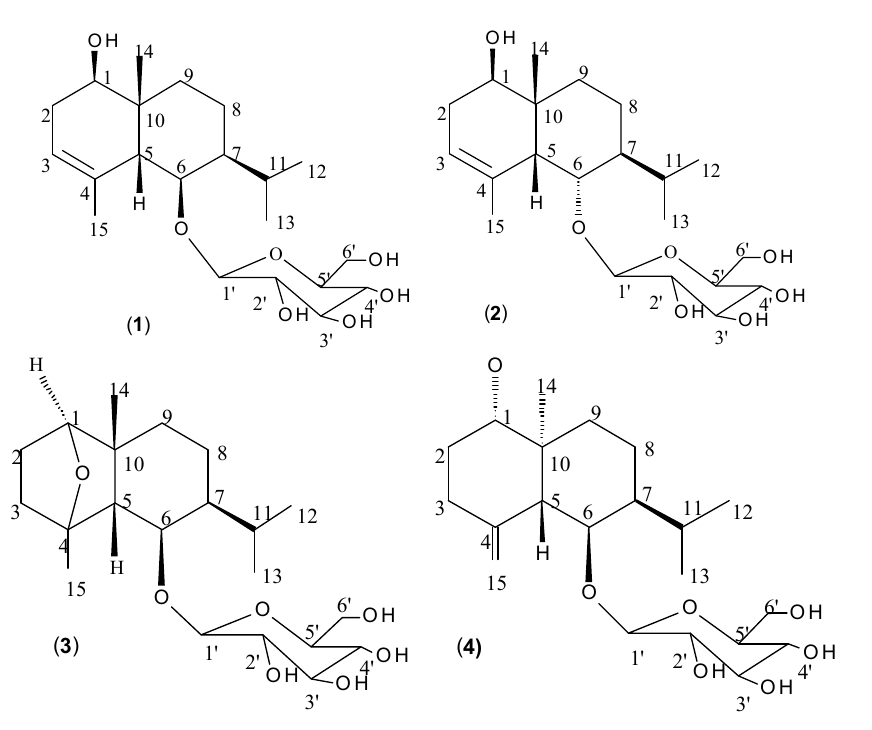
Figure 1. Structures of compounds isolated from Liriope muscari fibrous